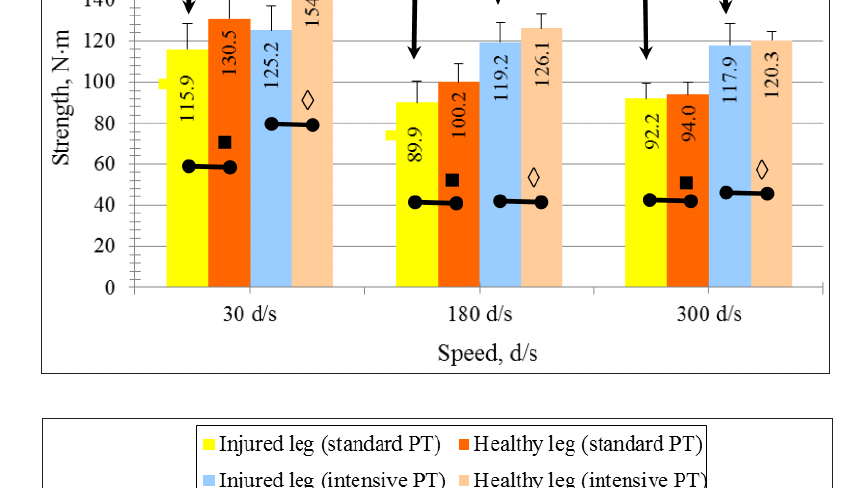
Figure 2. Healthy and injured leg, different physical therapy techniques, maximum muscular flexion strength at different speed of muscle contraction, before surgery